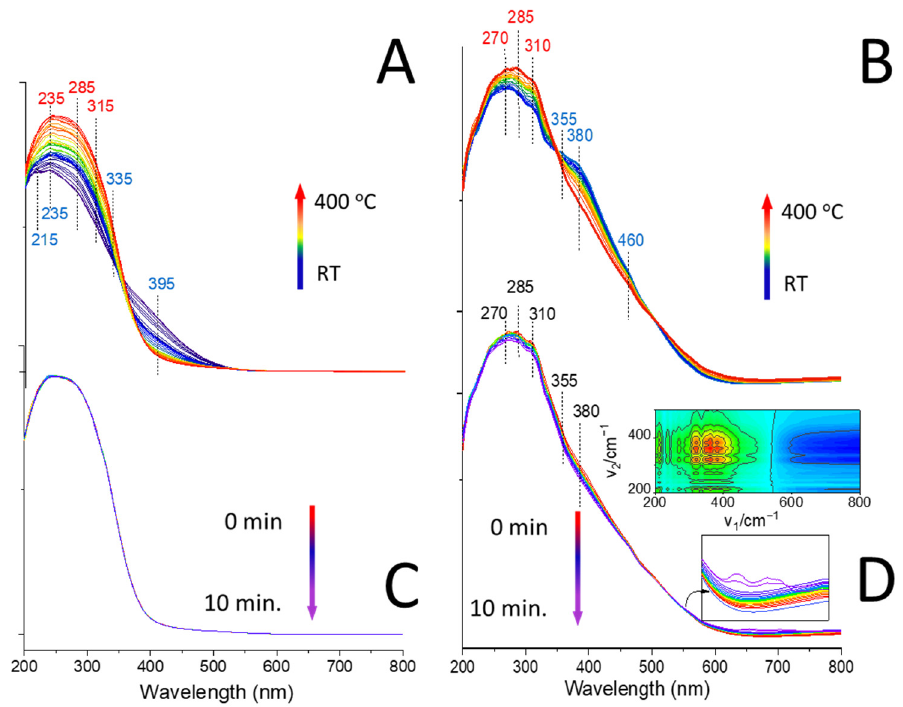
Figure 5. The DR UV-vis spectra of V-HY ( A , C ) and V-HY deSi ( B , D ) collected during the thermal Figure 5. The DR UV ‐ vis spectra of V ‐ HY ( A , C ) and V ‐ HY deSi ( B , D ) collected during the thermal pretreatment in synthetic air flow ( A , B ) upon contact with propane at 400 ◦ C ( C , D ). The 2D COS pretreatment in synthetic air flow ( A , B ) upon contact with propane at 400 °C ( C , D ). The 2D COS UV-vis maps as UV ‐ vis maps as inserts.